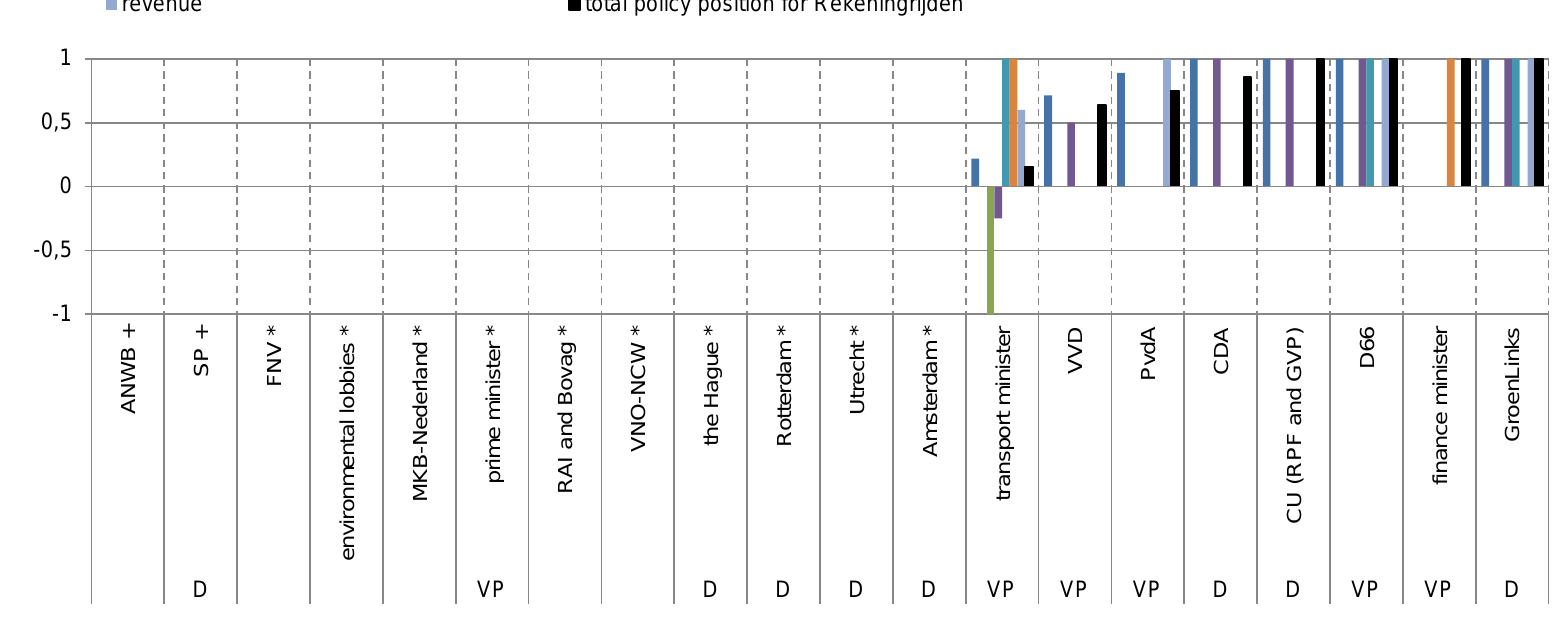
Figure 1. Pro- and anti- Rekeningrijden advocacy coalitions in government period 1 (1994 –